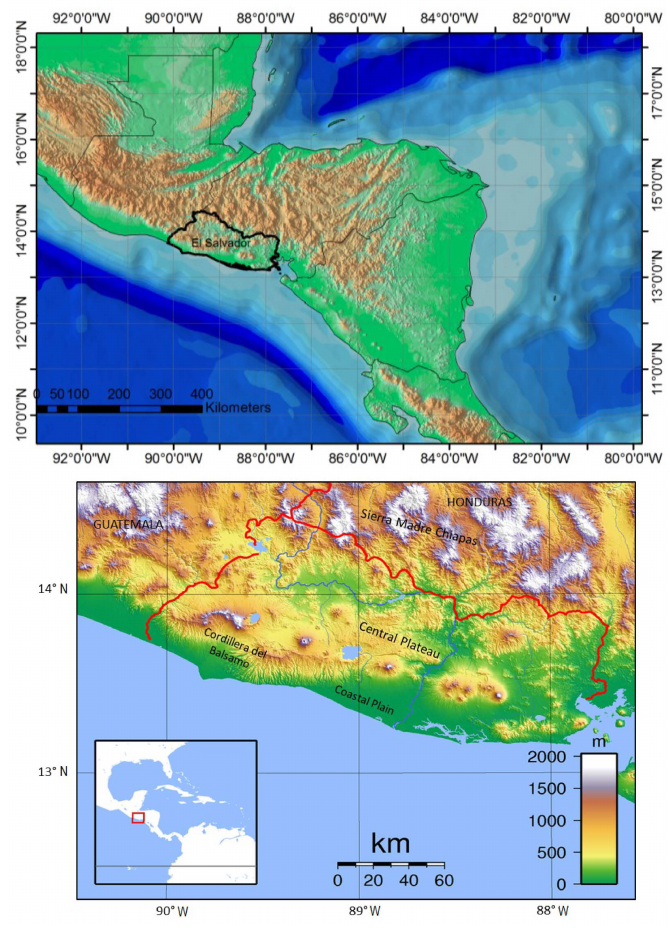
Figure 1. Location of the study area and topographic